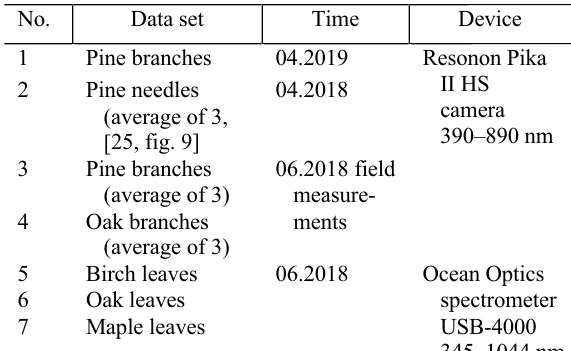
Fig. 6. Two main building blocks of the empirical compact model: Fermi­Dirac step and Gaussian bell functions.